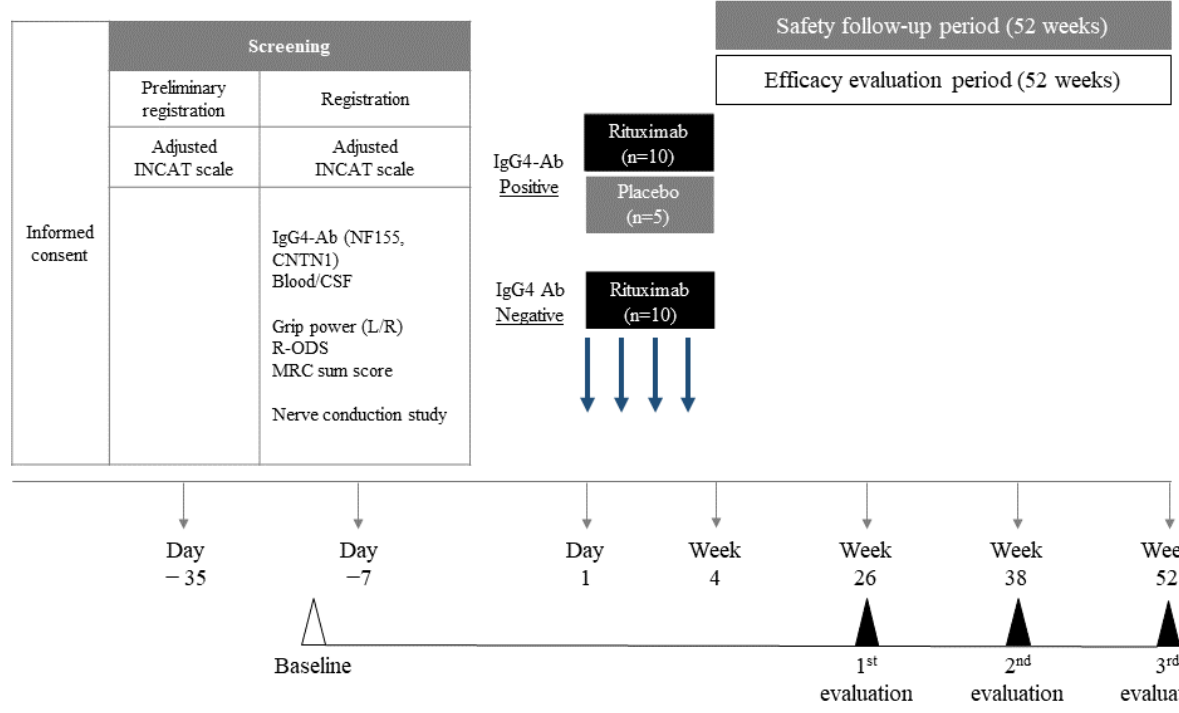
Figure 1. Measurement schedule. CNTN!: Contactin-1; CSF: cerebrospinal fluid; IgG4-Ab: immunoglobulin G4 antibodies; INCAT: Inflammatory Neuropathy Cause and Treatment; MRC: Medical Research Council; NF155: Neurofascin-155; R-ODS: Rasch-built Overall Disability